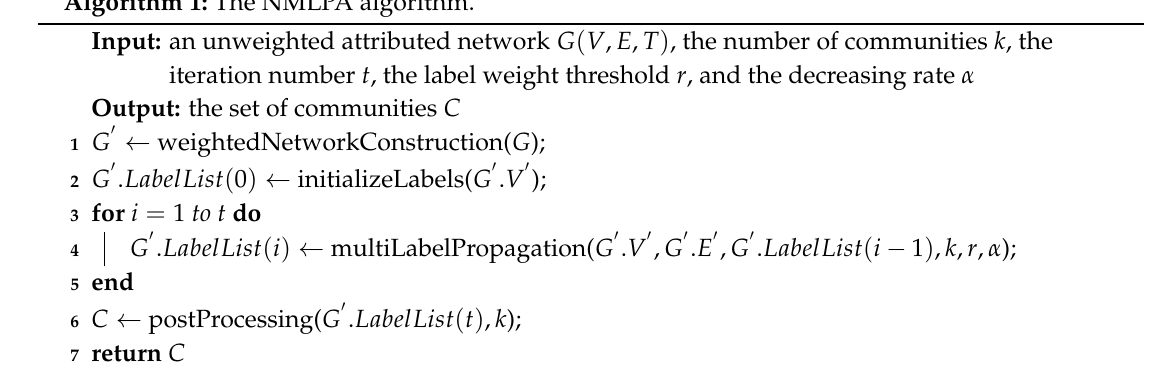
Algorithm 1: The NMLPA